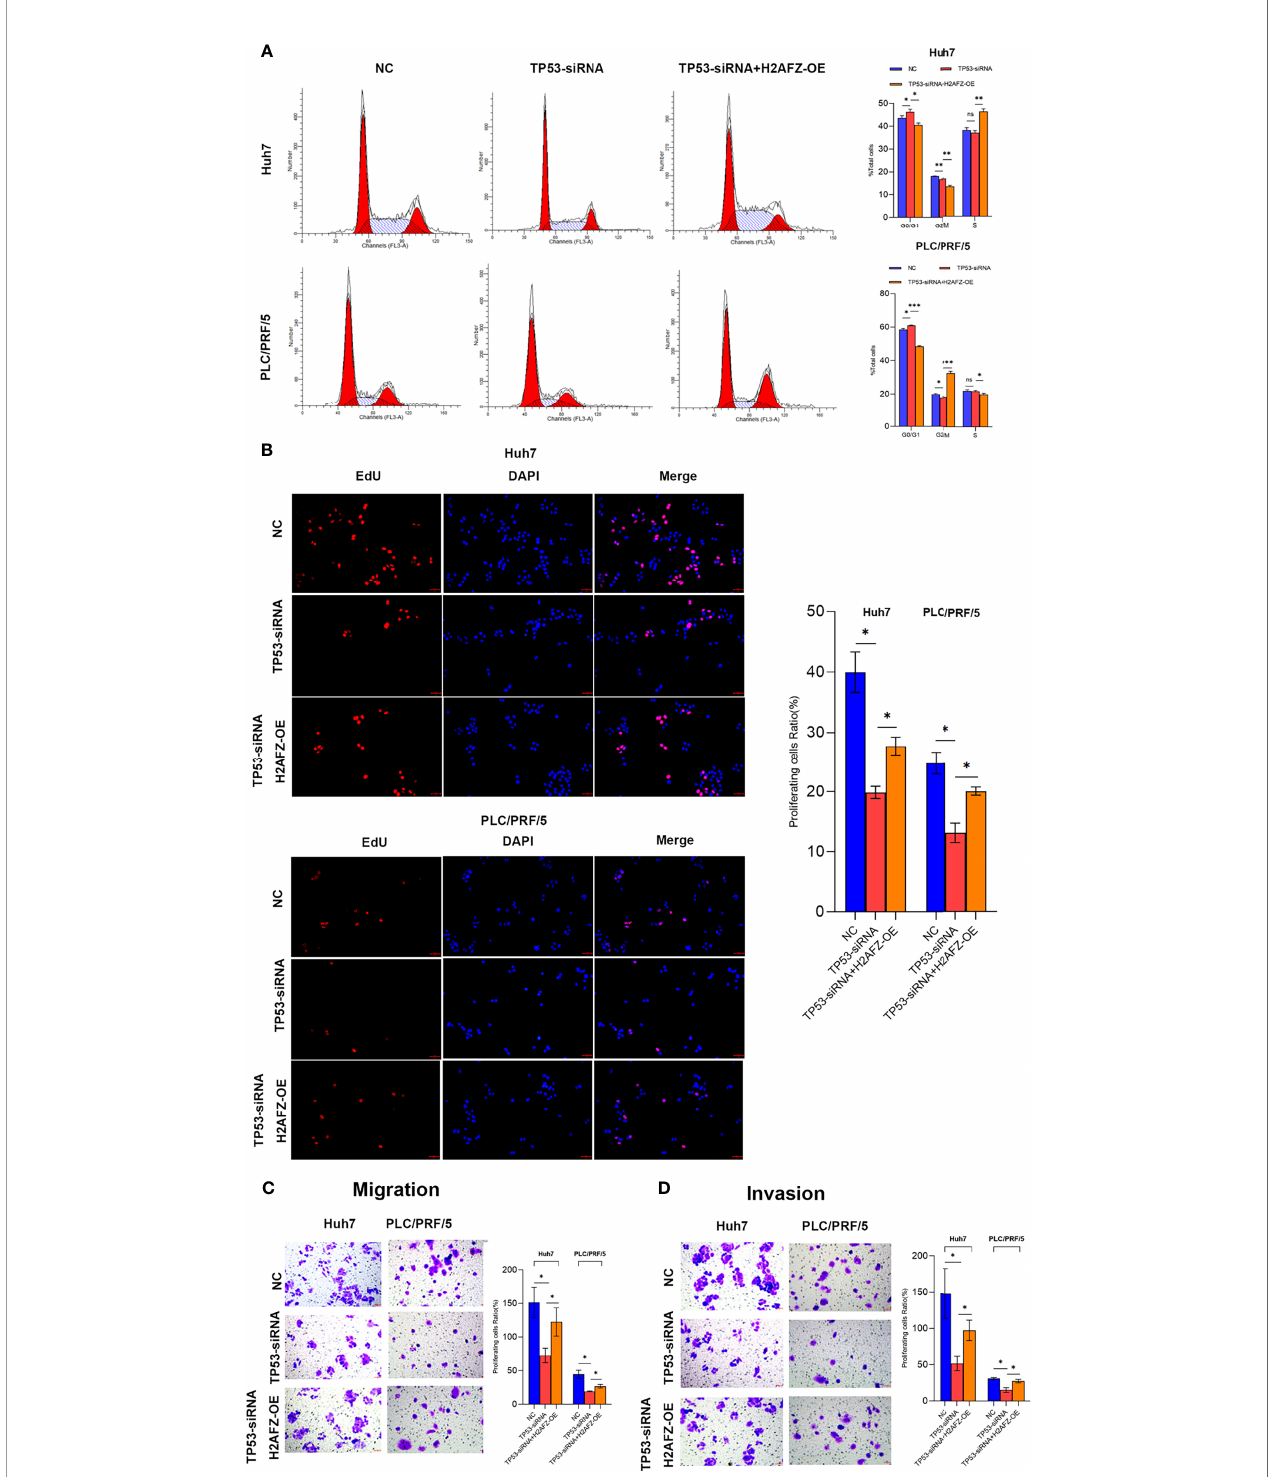
FIGURE 8 | H2AFZ overexpression enhances proliferation, migration and invasion capability of HCC cells in vitro . (A – D) Flow cytometry (FCM) assay (A) , 5-Ethynyl- 2 ’ -deoxyuridine (EdU) proliferation assay (bar = 50 m m, ×20) (B) , transwell migration assay (C) , and Matrigel-transwell invasion assay (D) on NC/TP53-siRNA/TP53- siRNA+H2AFZ-OE Huh7 and PLC/PRF/5 cells. T -tests ( n = 3), * p < 0.05, ** p < 0.001, *** p < 0.0001 ns, not signi fi